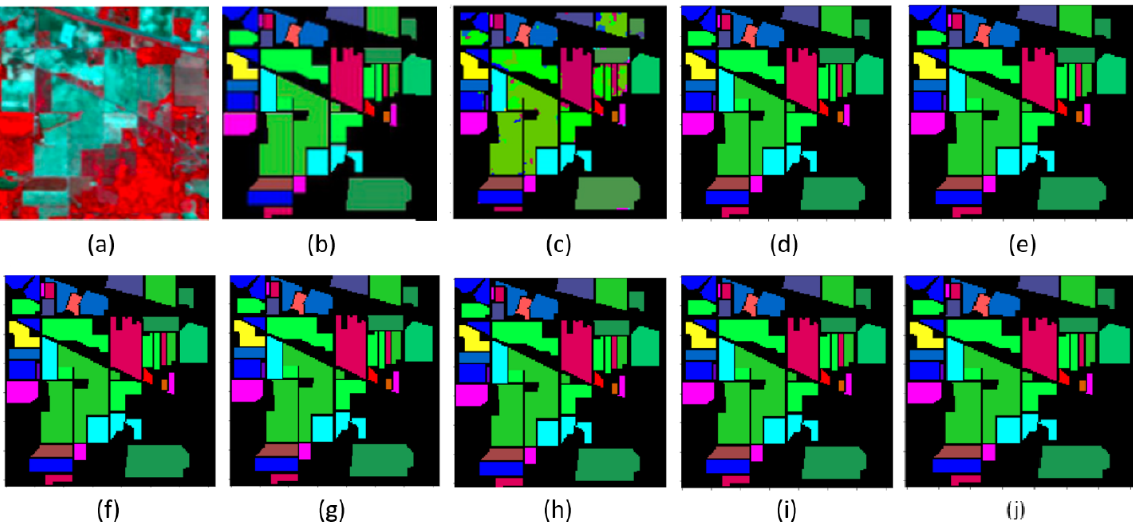
Figure 8. Indian Pines classification maps: ( a ) RGB (bands 32, 24, and 11) image; ( b ) ground truth; ( c ) SVM; ( d ) 2-D CNN; ( e ) 3-DCNN; ( f ) SSRN; ( g ) HybridSN; ( h ) DPSCN; ( i ) SE-DenseNet with cutout; and ( j ) SE-AB-DenseNet with cutout.